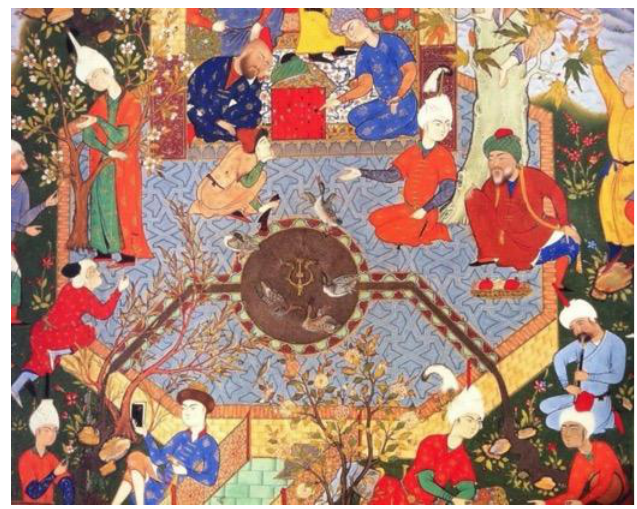
Figure 18. Safavid 16th c. miniature from “The Seven Thrones” of Jami (Khansari et al. 1998)